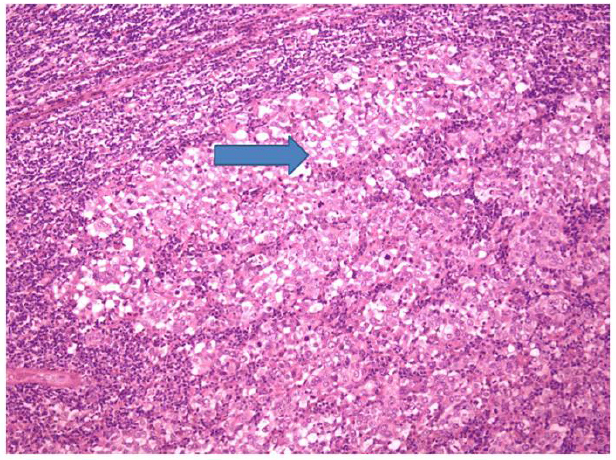
Figure 3. Metastatic lymph node